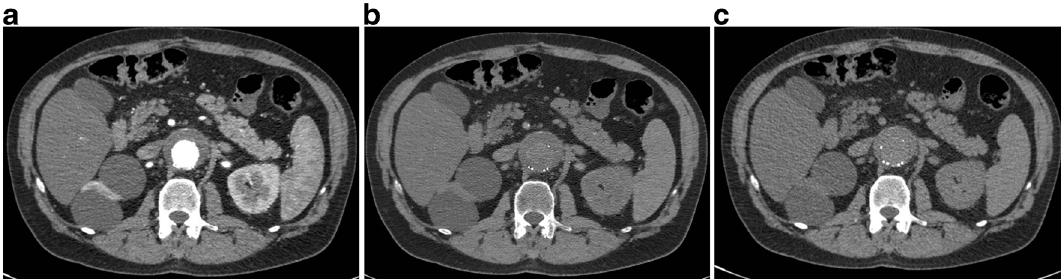
Fig.11 Virtualnon-contrast. ( a ) Axial 120-kVp routinediagnosticimage at the level of kidneys shows a contrast-filled stent graft lumen within the proximal abdominal aorta. ( b ) Virtual non-contrast reconstruction at the same level has removed the pixels which contained iodine. ( c ) Compare this with the true non-contrast image obtained at the same level, which